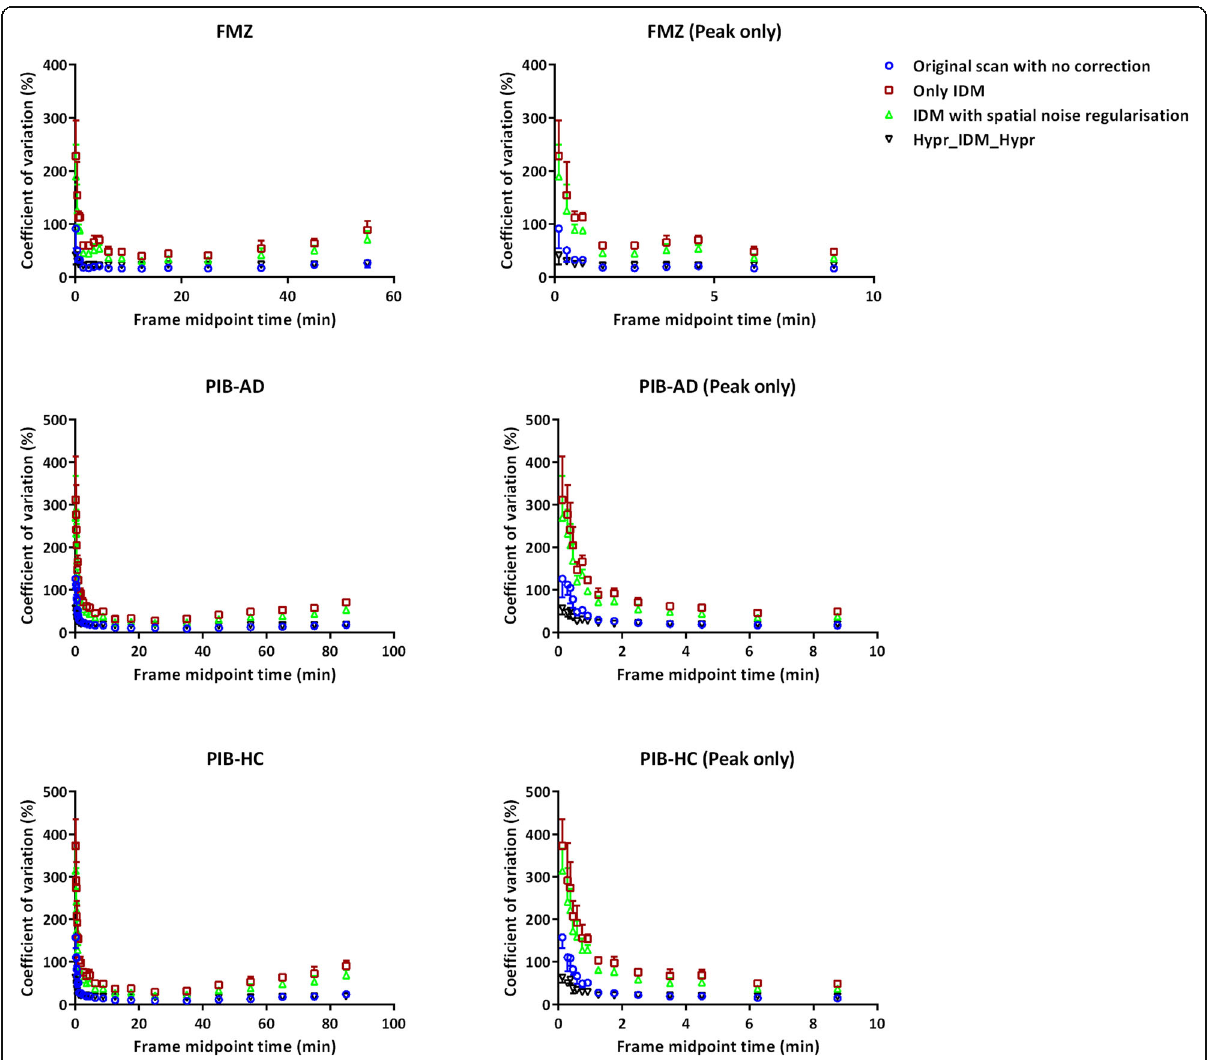
Fig. 7 Mean ± SD of coefficient of variation (%) of voxel values within the white matter volume of interest as function of frame midpoint time for FMZ scans and AD and HC PIB